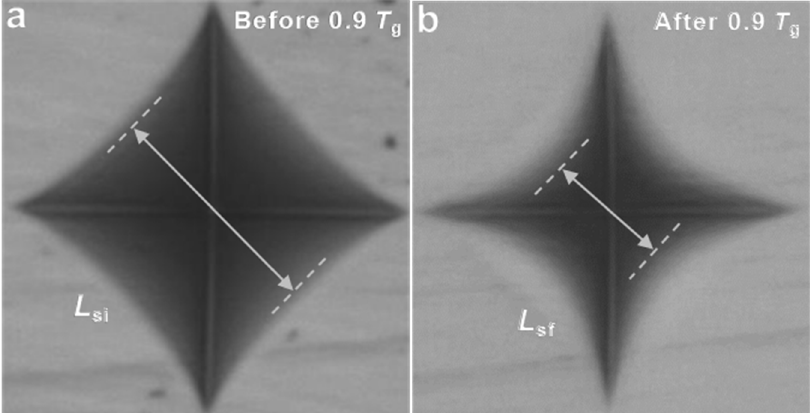
Figure 3. Optical micrographs of indents generated at 4.9 N on the surface of the CABS glass before and after re-annealing at 0.9 T g for 2 h.